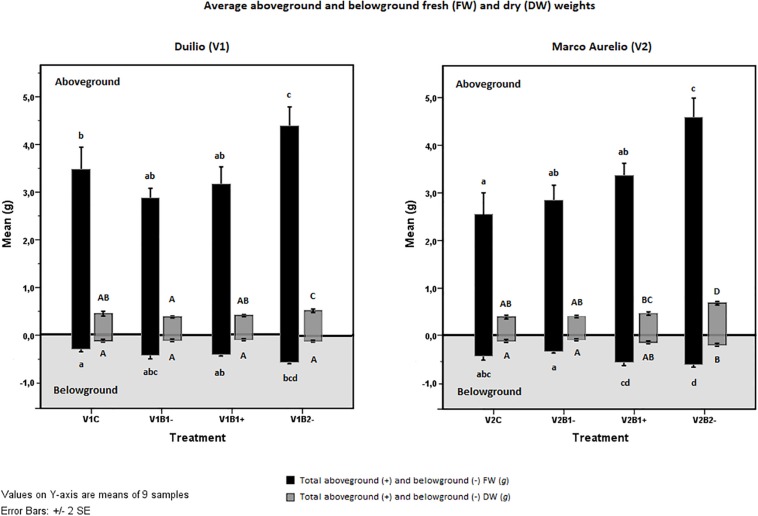
Effect of genotype and treatment on fresh weight (FW, black bars) and dry weight (DW, dark gray bars) in the aboveground plant (upper part on white background) and in the belowground root system (lower part on the light gray background). Duilio data is on the left; Marco Aurelio data is on the right. Letters close to the error bars indicate the homogeneous subsets resulting from Tukey HSD post hoc test (p < 0.05). Lower case letters refer to FWs and upper case to DWs.